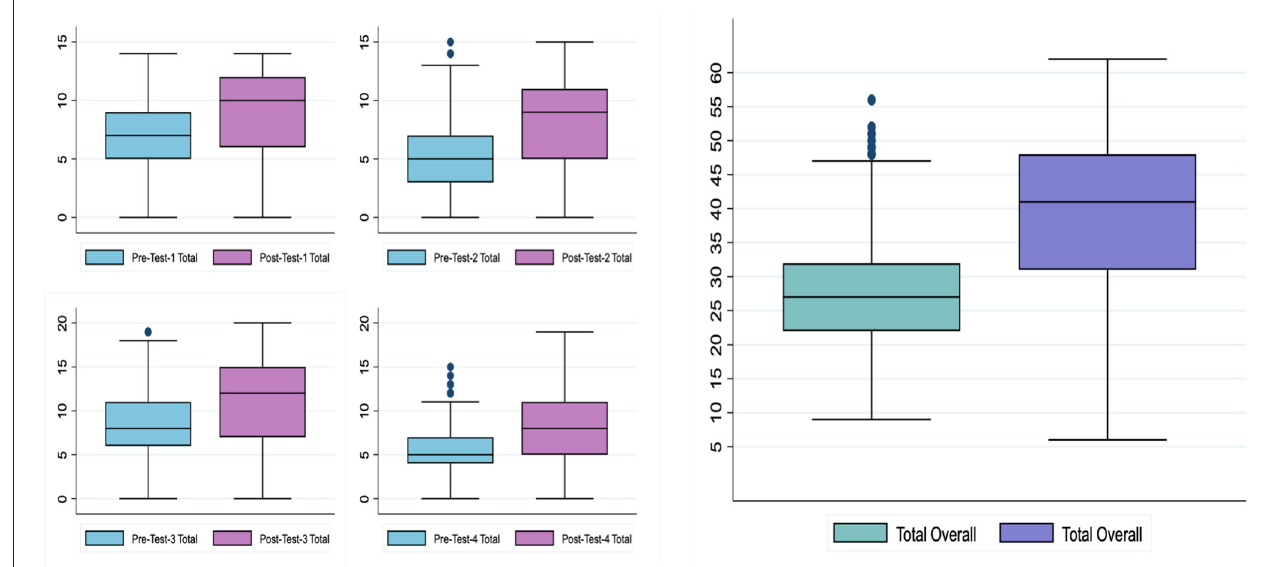
FIGURE 2 | Objective assessment: box-and-whisker plots showcasing changes in total scores from baseline pre-workshop aggregates to post-workshop aggregates.